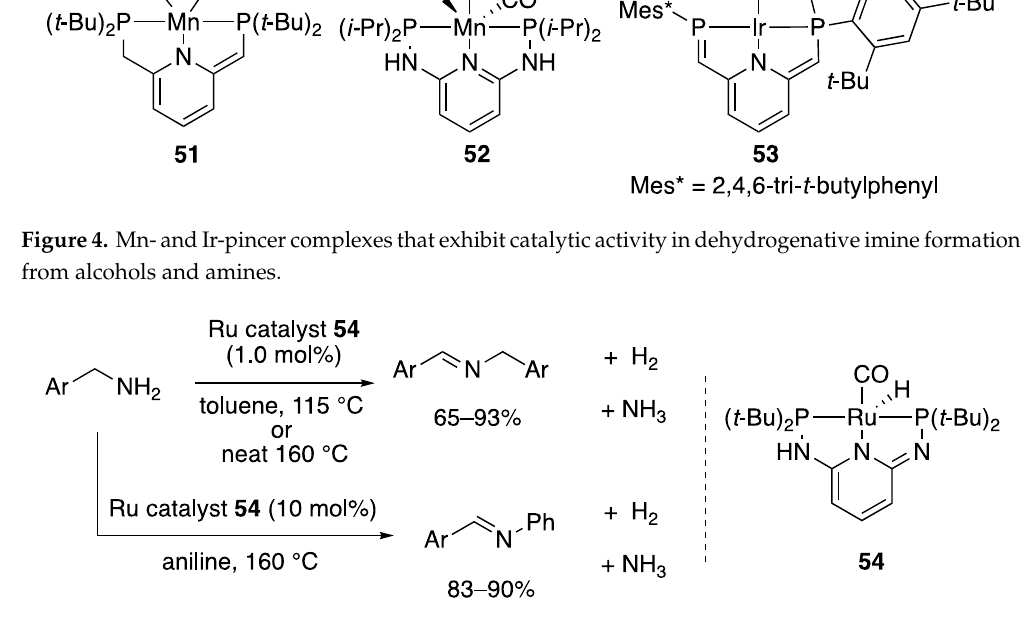
Figure 4. Mn- and Ir-pincer complexes that exhibit catalytic activity in dehydrogenative imine formation from alcohols and